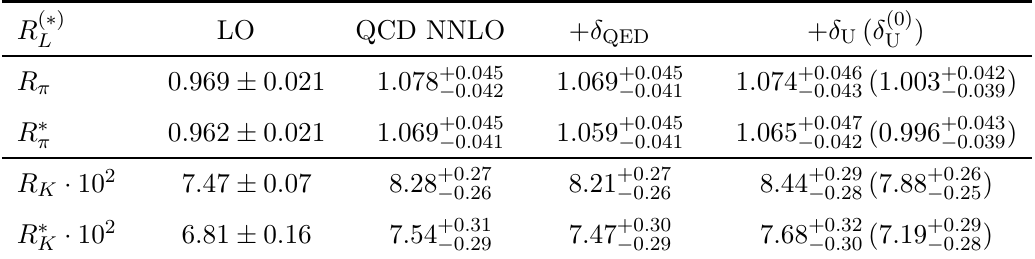
expressed in GeV 2 at LO, NNLO QCD and subsequently L (or in brackets δ (0) ). The last column U U